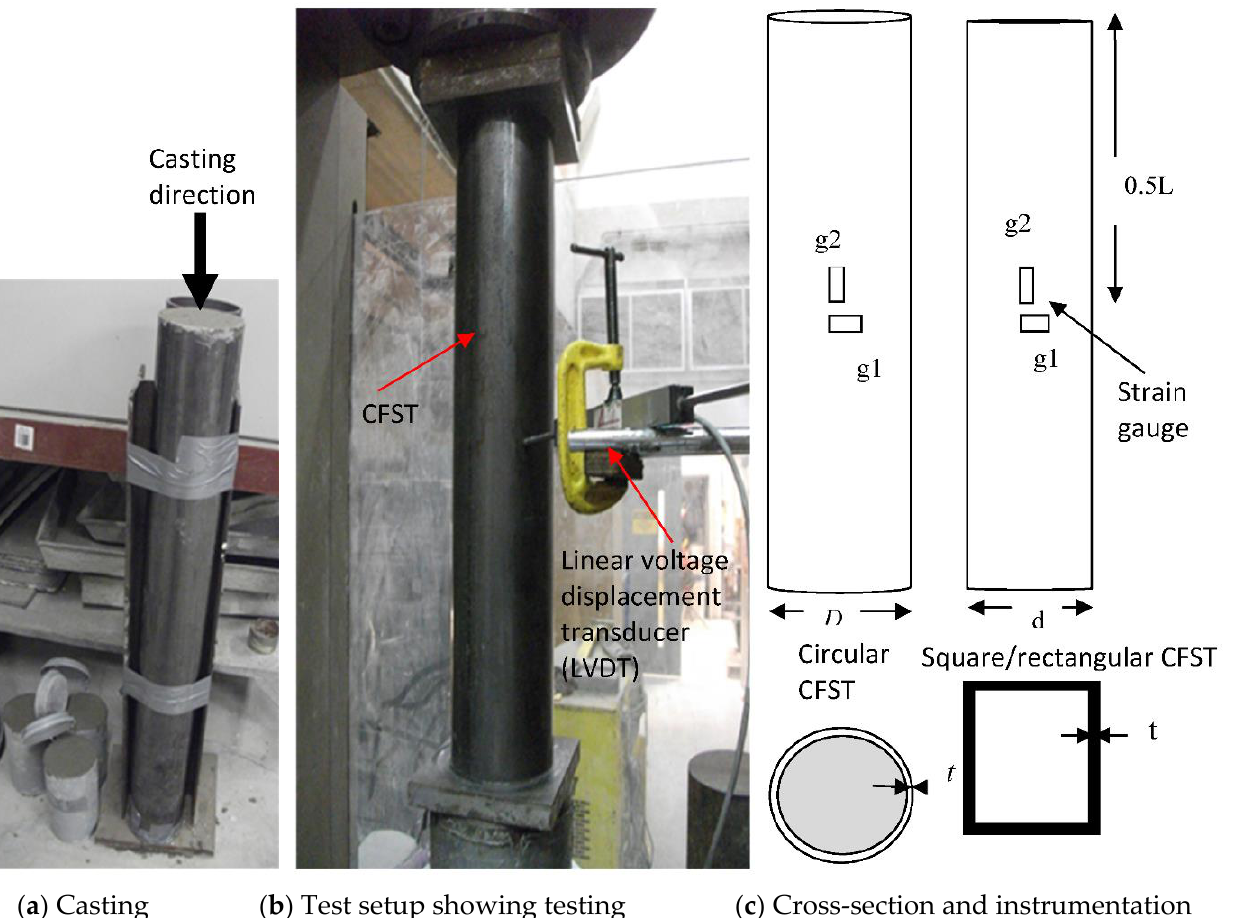
Figure 3. Typical compressive stress-strain and flexural stress-displacement responses of UHSC.